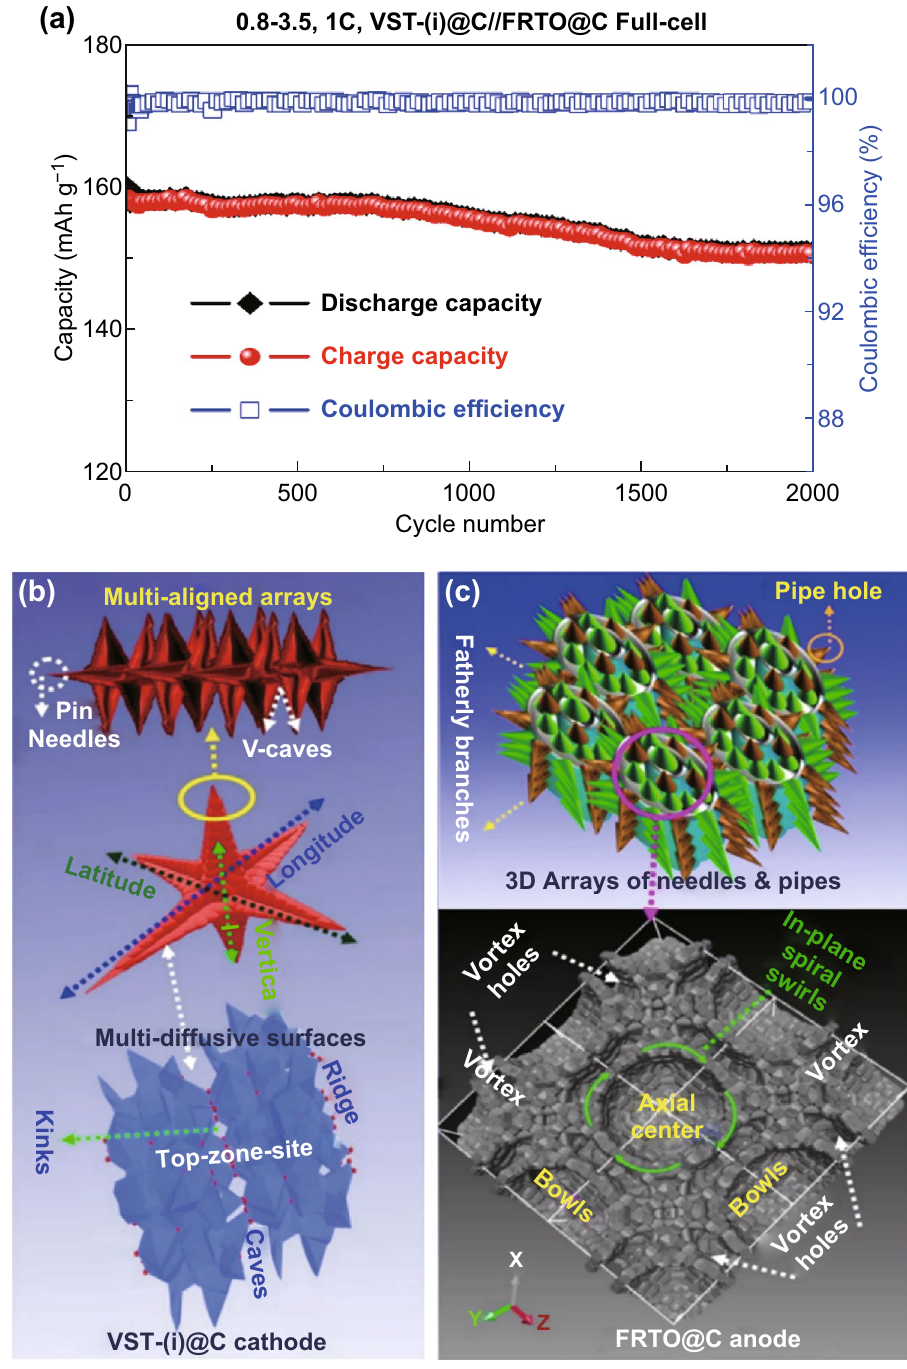
Fig. 6 a Long‑term cycling performance (stability) and Coulombic efficiency for a scalable full‑cell VST‑(i)@C//FRTO@C hierarchy at a rate of 1 C up to 2000 cycles and in the voltage range 0.8–3.5 V at room temperature. b , c 3D modeling projects of multi‑directional along the verti‑ cal, lateral, and longitudinal axes of the super‑hierarchical nano‑architectures of VST@C cathode and FRTO@C anode electrodes. The retention of configuration in 3D‑planes and modulate crystal structure surfaces (bottom) on the cathode and anode were evident. In‑plane view projections of surface crystal modules recorded in a direction parallel to the upper atomic surfaces cathode/anode electrodes were investigated by DFT cal‑ culations after the multiple lithiation/delithiation (discharging/charging) cycling